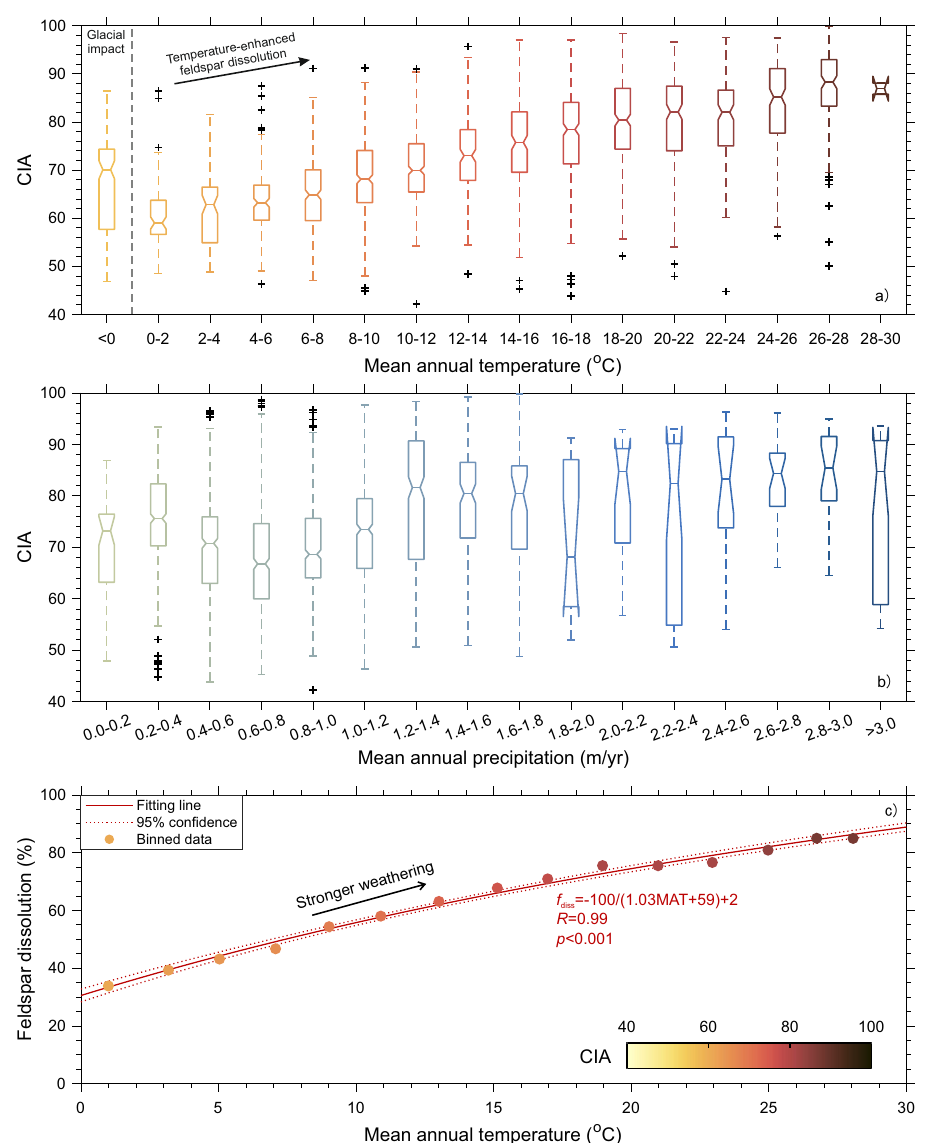
Fig. 4 Control of temperature versus precipitation on CIA. a , b Boxplots of CIA grouped by zones of MAT ( a , interval of 2 °C) and MAP ( b , interval of 0.2 m/yr). The notch of each box displays the variability of the median: if the notches of both boxes do not overlap, their medians are signi fi cantly different at the 5% level. The box limits are 25th and 75th percentiles, the whiskers represent the 1.5× interquartile range, and the “ + ” symbols are outliers. CIA increases monotonically with MAT and shows a more complicated pattern with MAP. The patterns of WIP (Supplementary Fig. 3) are similar to those of CIA shown here. c Empirical relationship between MAT and percentage of feldspar dissolved ( f diss , %) converted from average sediment CIA (Methods) binned by temperature (an interval of 2 °C, MAT >0 °C, Supplementary Fig. 6). The non-negligible f diss under low MAT (~0 °C) might be partly contributed by sedimentary rock outcrops that have been weathered before exposure. However, the impact of such f diss baseline in a speci fi c region can be largely reduced when calculating relative changes of f diss with